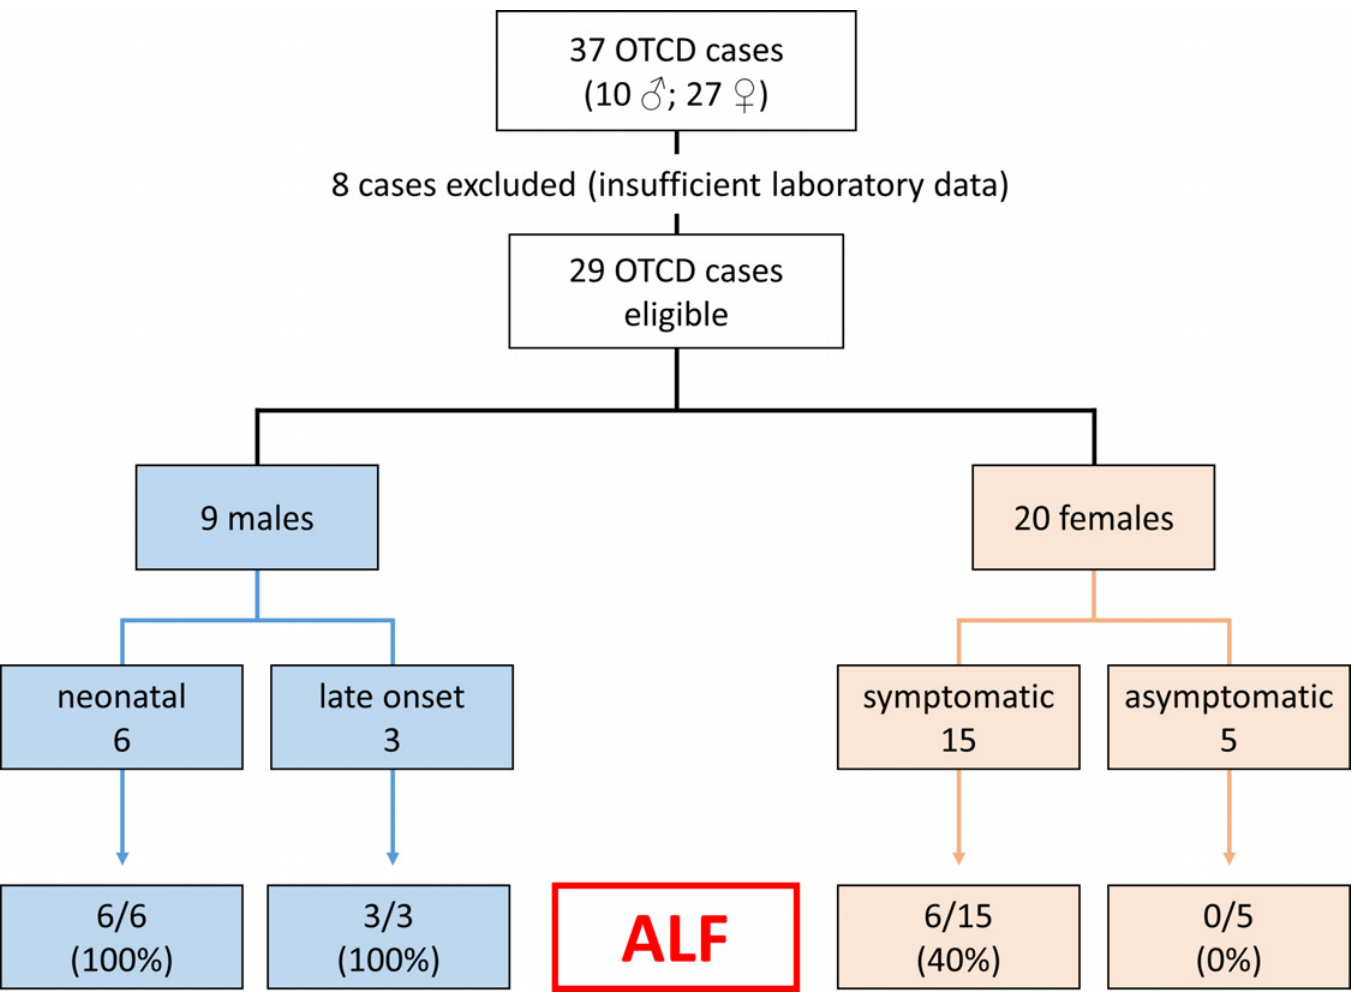
Fig 2. Overview of included patients and occurrence of acute liver failure. From 37 cases, 29 were eligible for further studies regarding occurrence of acute liver failure (ALF). Male patients are shown as neonatal (onset in the first month of life) and late onset (symptoms beyond the first month of life) cases. Females are classified as symptomatic or asymptomatic. The bottom boxes indicate the occurrence of